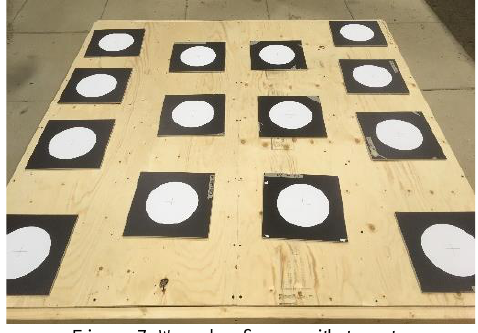
Figure 7. Wooden frame with